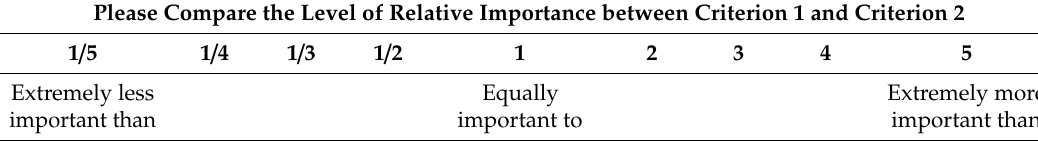
Table 1. The rank scales of pairwise comparison for assessment